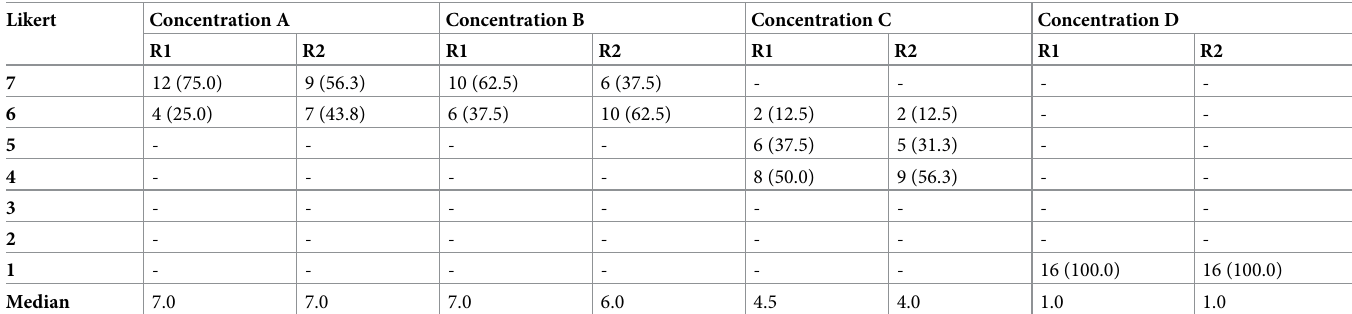
Table 1. Observer ratings for Gd-DOTA dilution series. Subjective evaluation of stenosis phantoms with different Gd-DOTA concentrations ( n = 16 each) using a seven-point Likert scale (7 = excellent; 6 = very good; 5 = good; 4 = satisfactory; 3 = fair; 2 = poor; 1 = very poor). Scale results are displayed as frequencies (percentages) and median values. Concentration A: 10.2 mM. Concentration B: 5.1 mM. Concentration C: 1.0 mM. Concentration D: NaCl. Reader 1 / reader 2: R1 /